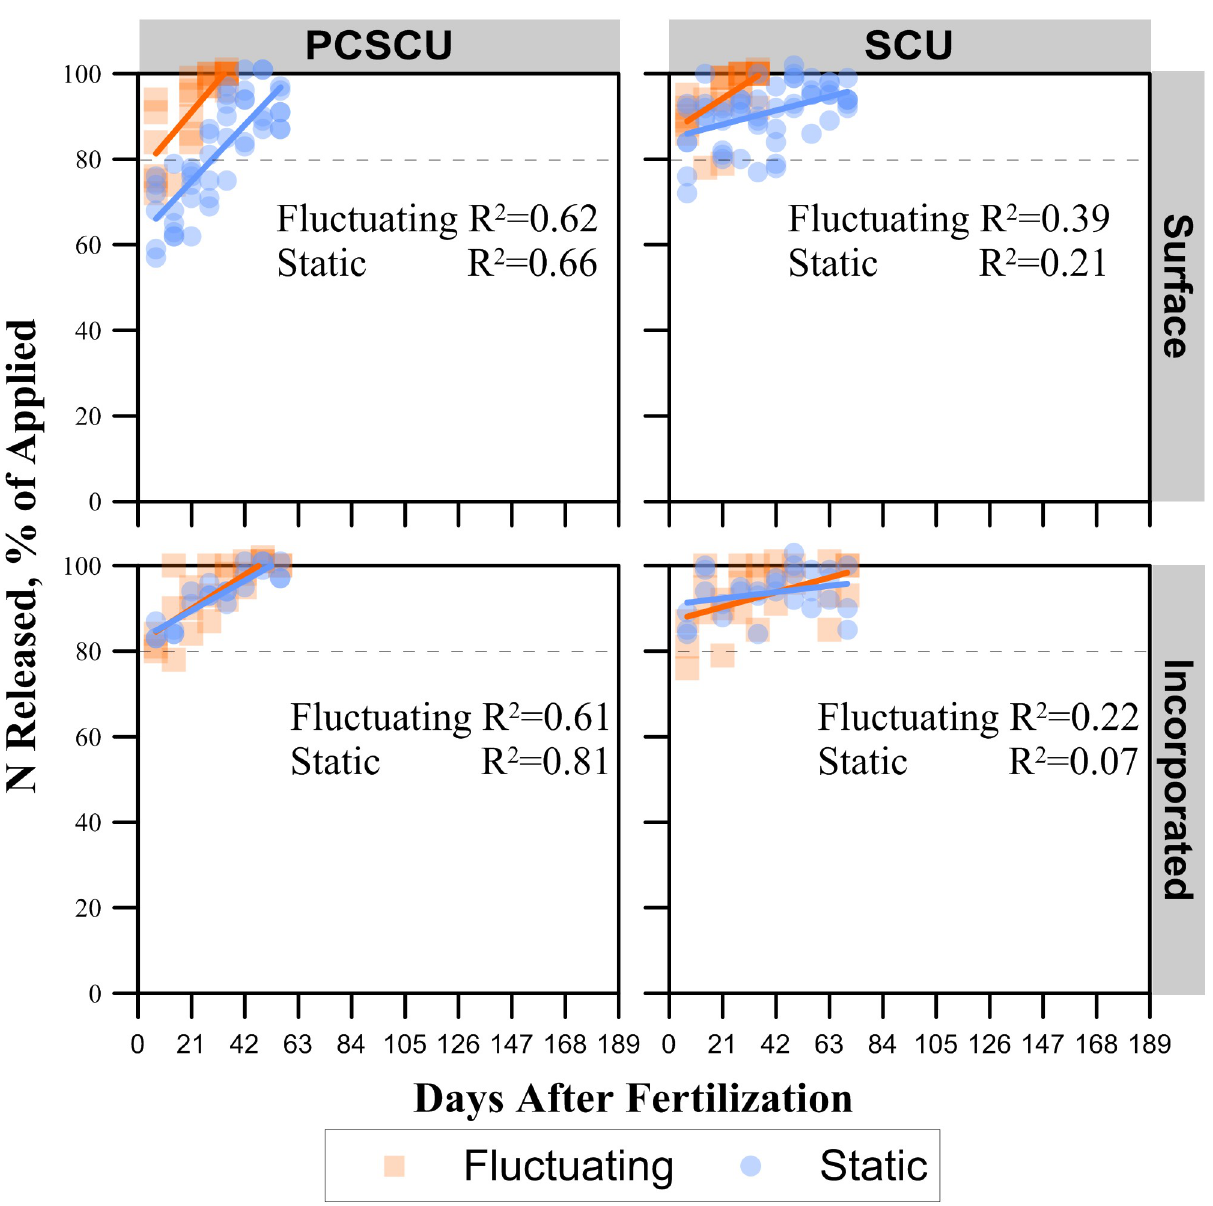
Fig 5. Experiment 1 N release rates for various fertilizer sources. (PCSCU) polymer-coated sulfur-coated urea, and (SCU) sulfur coated urea applied either to the soil/thatch layer surface or incorporated into the soil at either static or fluctuating daily temperatures. The dashed vertical line indicates the targeted cumulative release